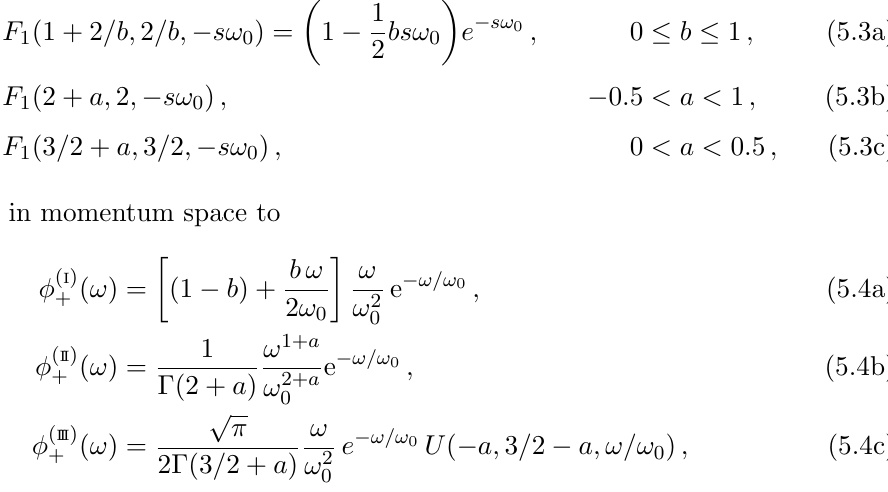
, ^ (cid:27) and ^ (cid:27) are 1 2 B